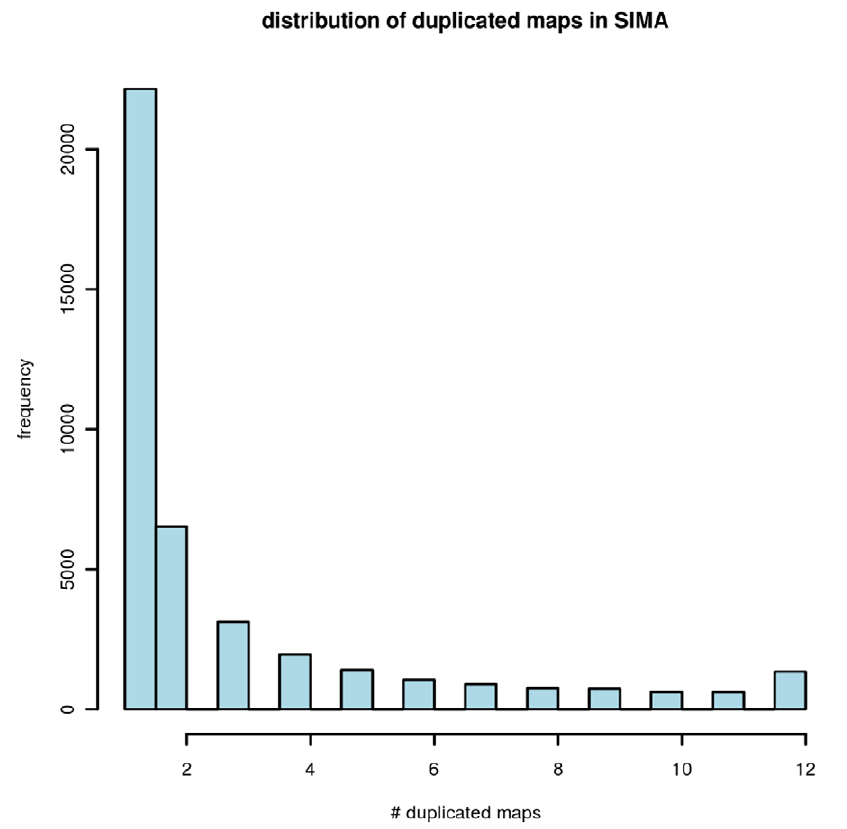
Figure 2. The distribution of duplicated maps in SIMA (mass resolution 0.0071 Daltons) consensuses alignment based on all 24 maps. The horizontal axis represents the number of Type-I errors in the generated consensuses. These range from one to 12. The vertical axis represents the frequency.